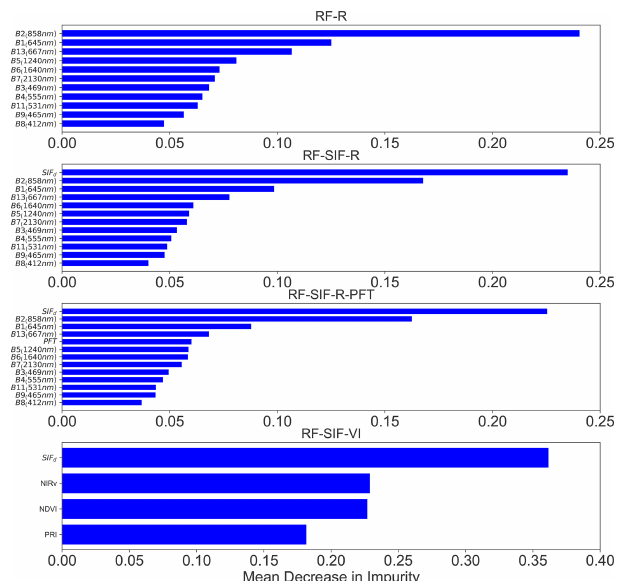
Figure 9. Relative importance of predictive variables of the RF models based only on remote sensing data for estimating GPP, ex- cept for the RF-SIF- R -PFT model. The RF- R model is based only on MODIS surface spectral reflectance; the RF-SIF- R model uses SIF d and surface reflectance as input variables; the RF-SIF- R -PFT model integrates SIF d , surface reflectance, and PFT as explanatory variables; and the RF-SIF-VI model combines SIF d and reflectance- based indices, notably NDVI, NIR v , and PRI, as input variables for predicting GPP across all sites. The wavelengths depicted on the spectral bands denote the central